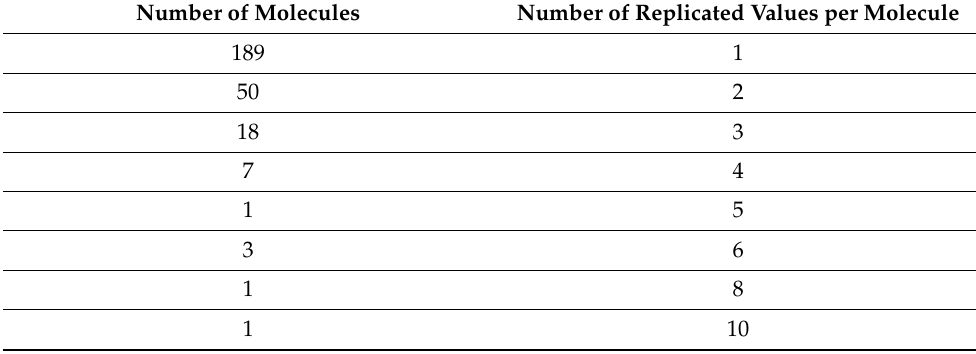
Table 1. Summary of the replicated values of training dataset.